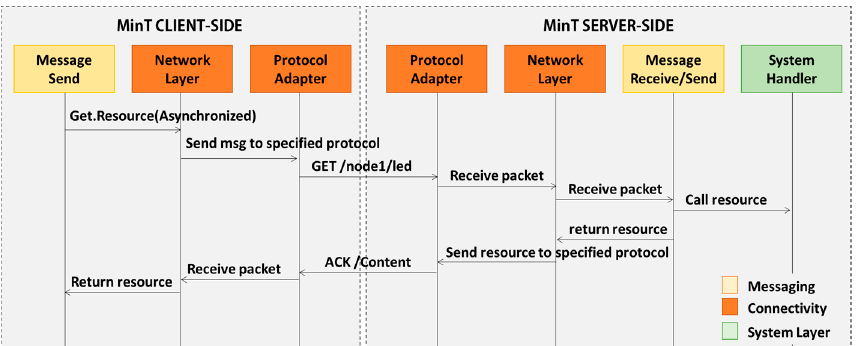
Figure 6. Messaging sequence diagram on MinT.